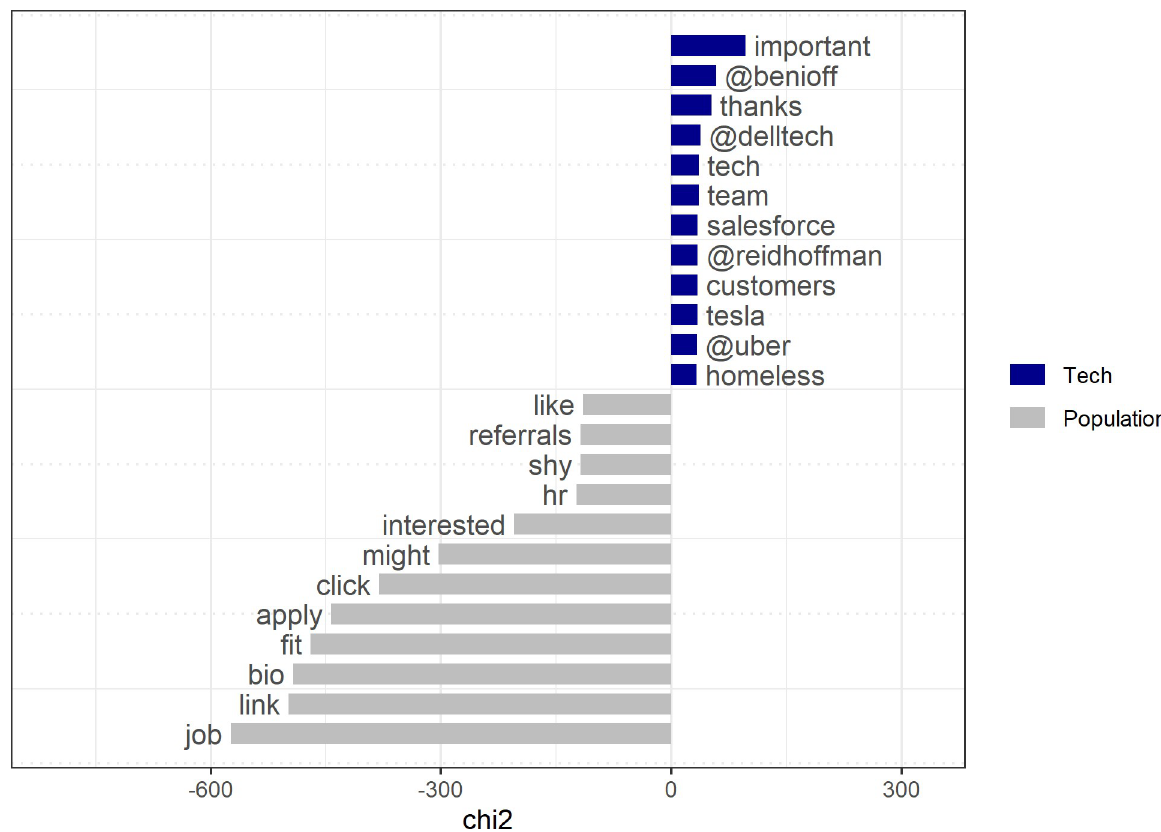
Fig 5. Keyness statistics for tweets with “merit” and related